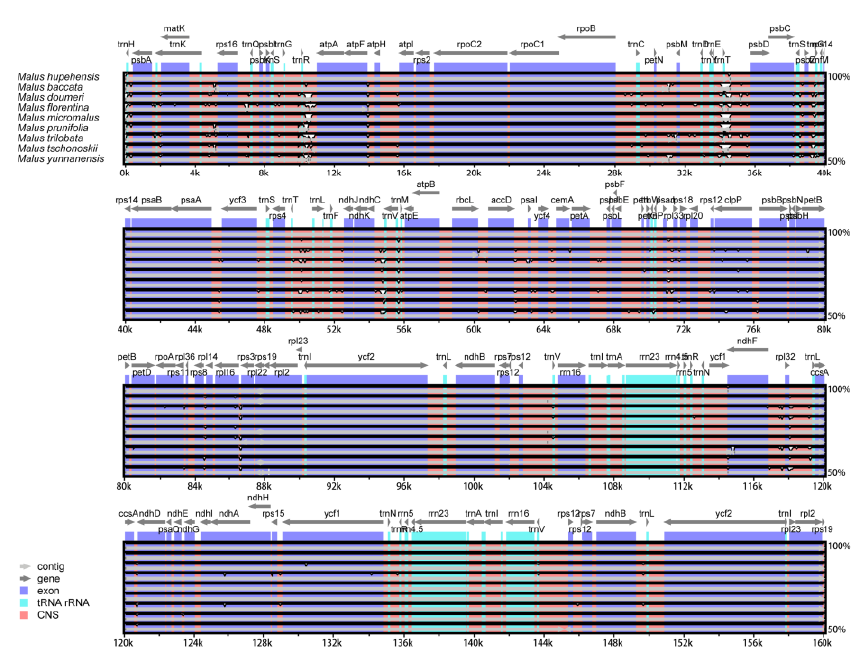
Figure 5. Comparison of nine cp genomes using mVISTA. The chloroplast genome of M. hupehensis as a reference. The grey arrows and thick black lines above the alignment indicate the position and direction of each gene. The y-axis represents the percentage identity (shown: 50 – 100%).